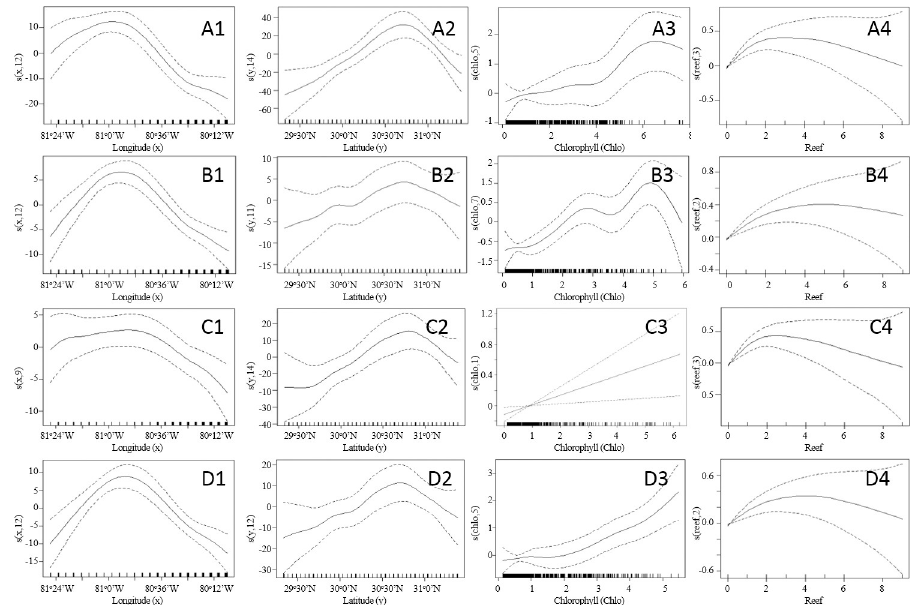
Fig 3. Smoothed curve of the additive effect of covariates modeling the abundance of offshore recreational boating trips in the southeastern United States. Winter (A), Spring (B), Summer (C), and Fall (D). Predictor variables include longitude (x), latitude (y), chlorophyll a concentrations (Chlo), and abundance of artificial reefs (Reef). Solid line depicts the estimate of the smooth function and dashed lines indicate 95% confidence bands. Estimated degrees of freedom for each smoothed variable are shown on the